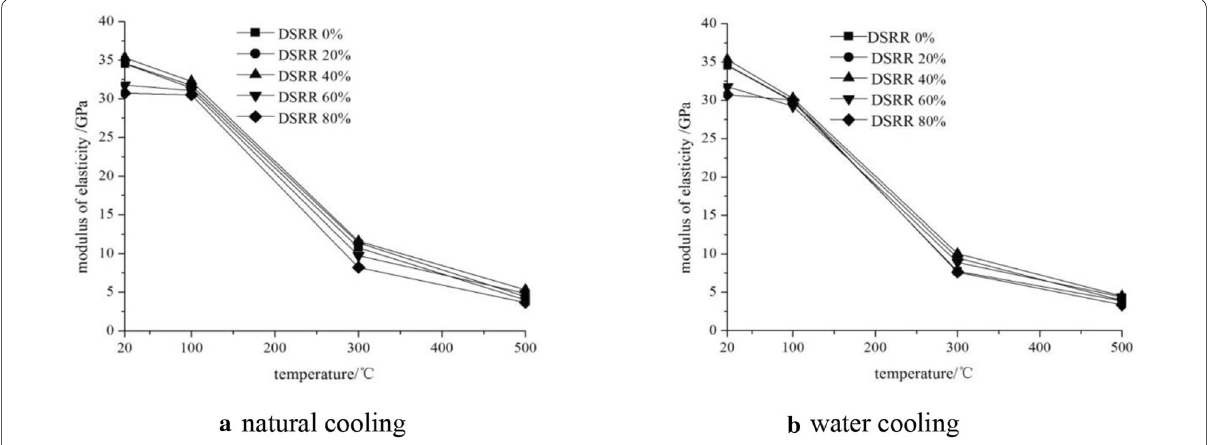
Fig. 14 Relation between elasticity modulus of concrete produced with desert sand and